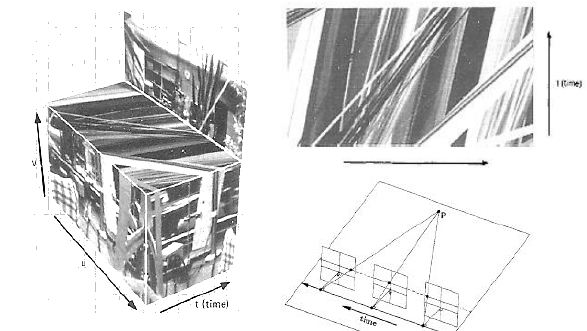
Figure 1. Illustration of the light field requirements, epiplanar slice of the epibloc and epibloc (Bolles et al., 1987).